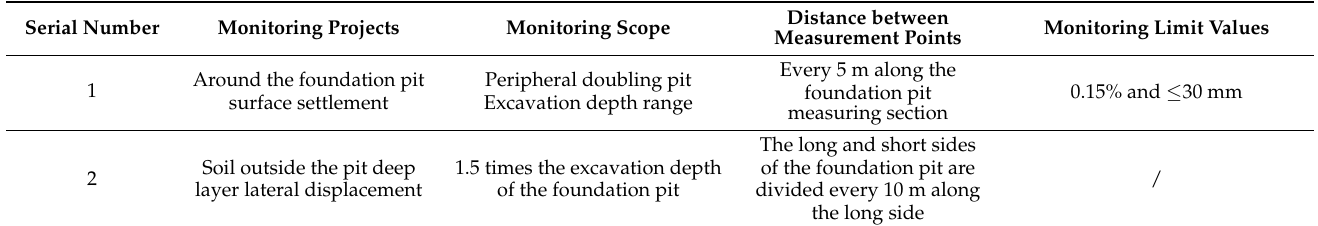
Table 2. Monitoring and measuring table of foundation pit.